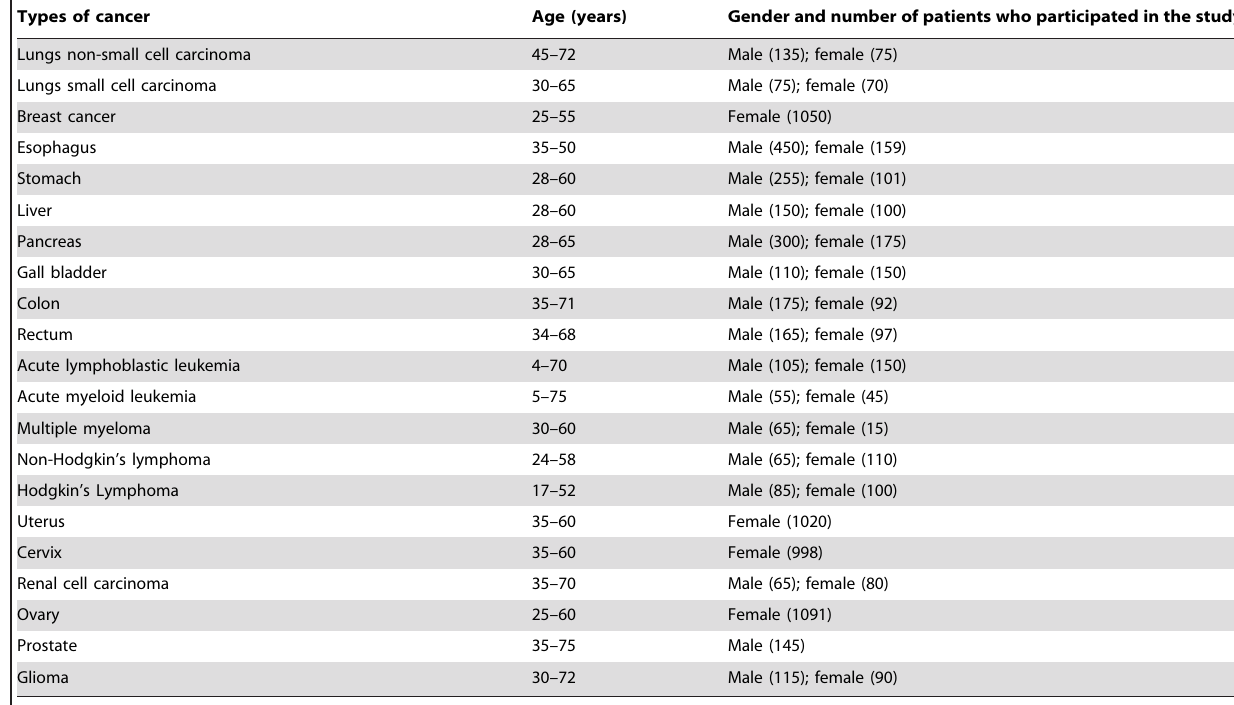
Table-2. Cancer entities of the patients selected for the study.